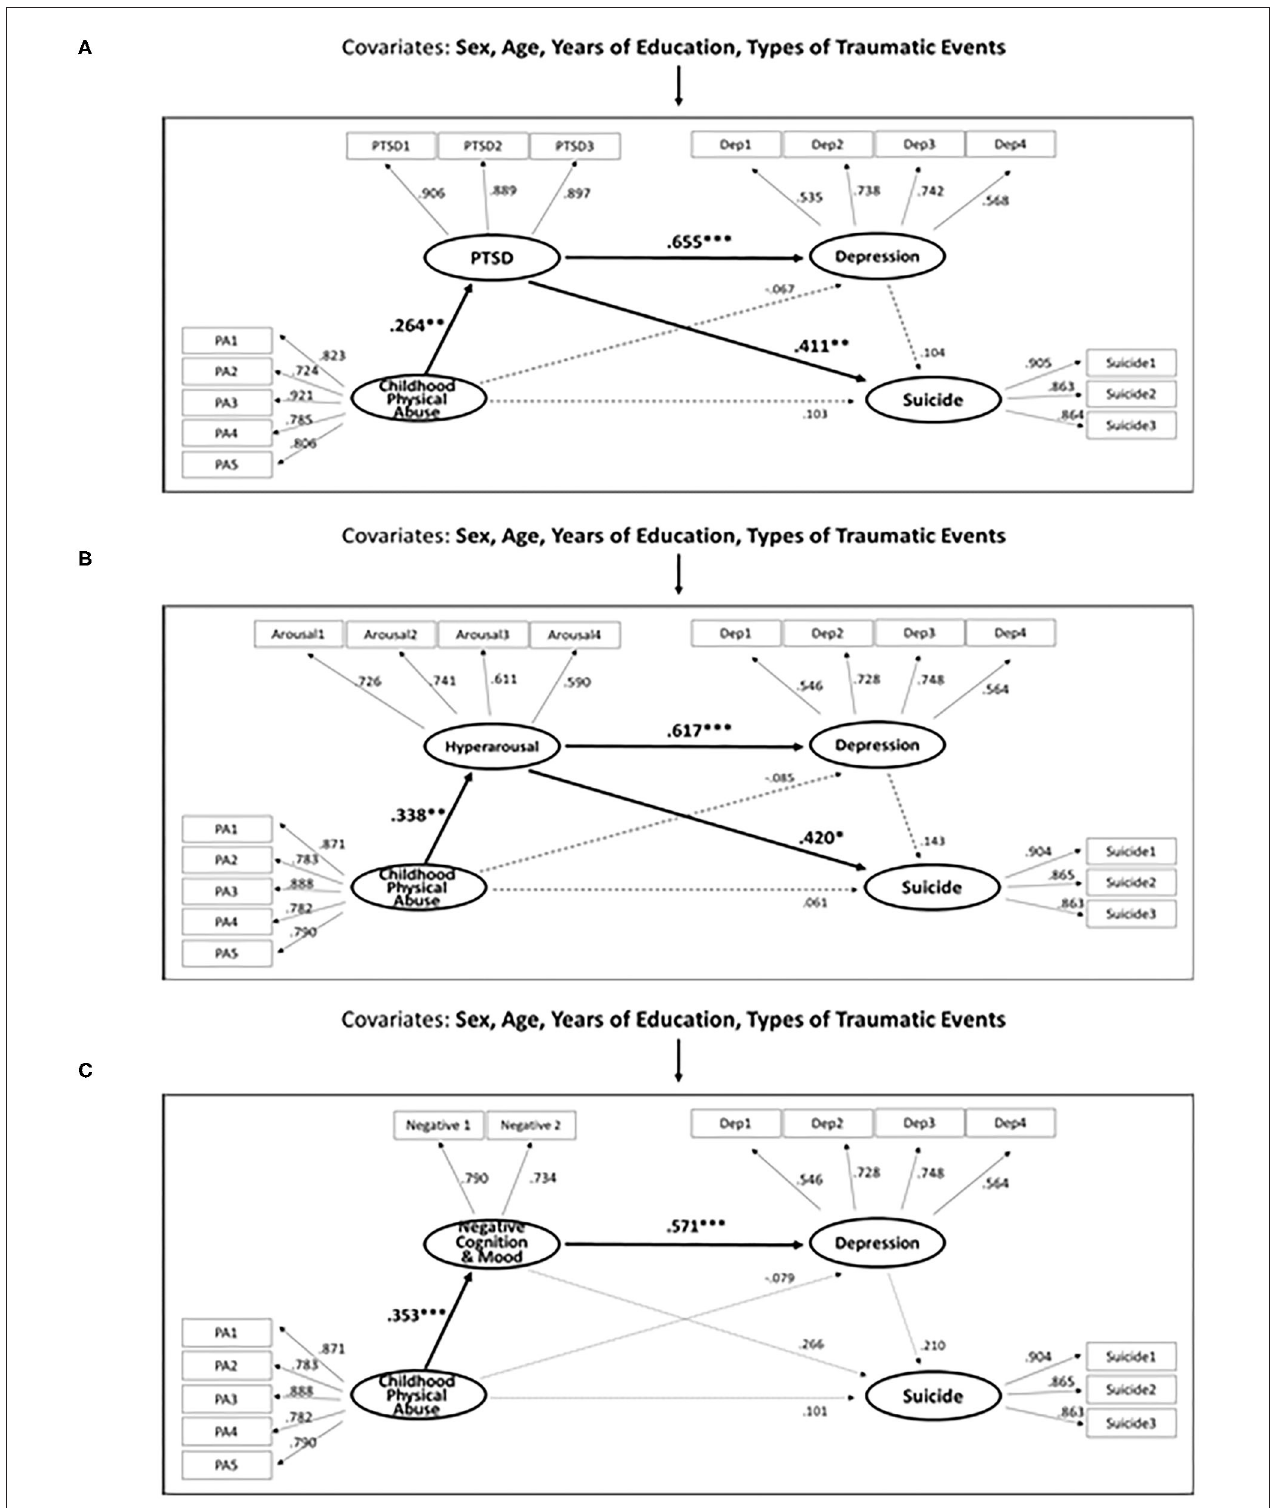
FIGURE 2 | (A) Structural equation model of the effects of childhood physical abuse, PTSD and depression on suicide in patients with PTSD ( N = 114). (B,C) Structural equation model of the effects of childhood physical abuse, specific PTSD symptom cluster and depression on suicide in patients with PTSD ( N = 114).